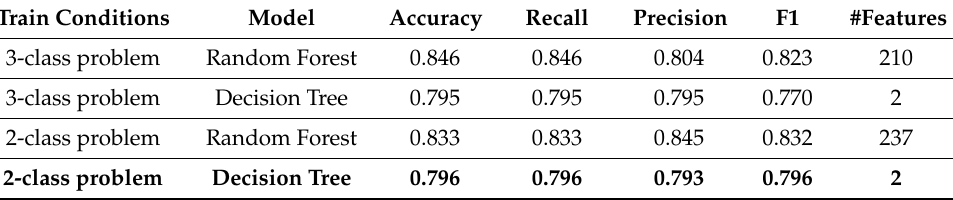
Table 8. Classification results for shadows and reflections using an independent ML model for DT. Train Conditions